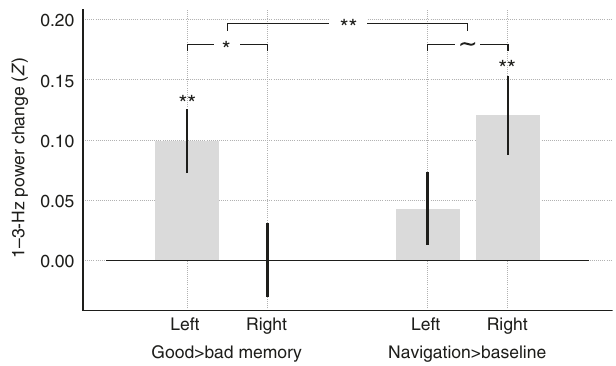
Fig. 6 Laterality of memory and navigation effects. Task-related 1 – 3-Hz power changes within left ( N = 26) and right ( N = 21) hippocampus, as measured by the difference in mean z -scored power, is shown for the recalled/not recalled contrast and the navigation/baseline contrast.